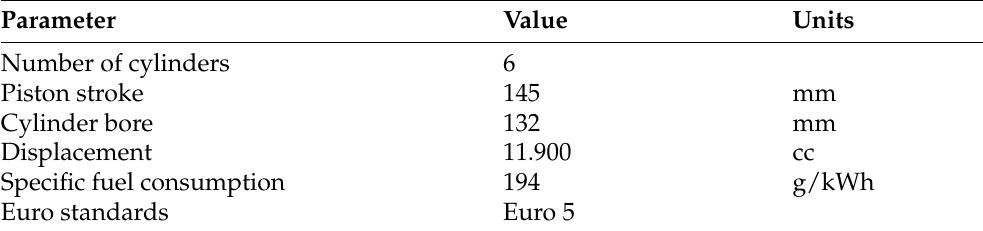
Table 2. Additional parameters of DEUTZ TCD 12.0 V6 diesel engine